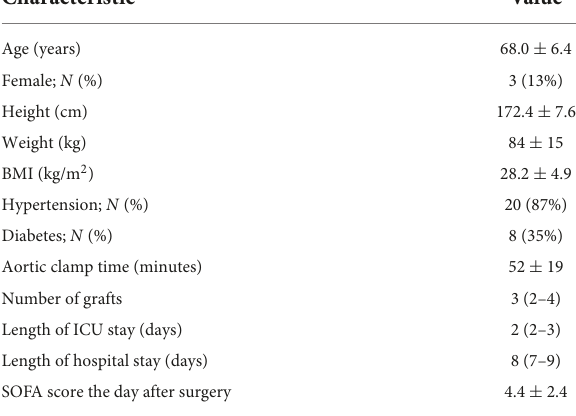
TABLE 1 patient characteristics of the 23